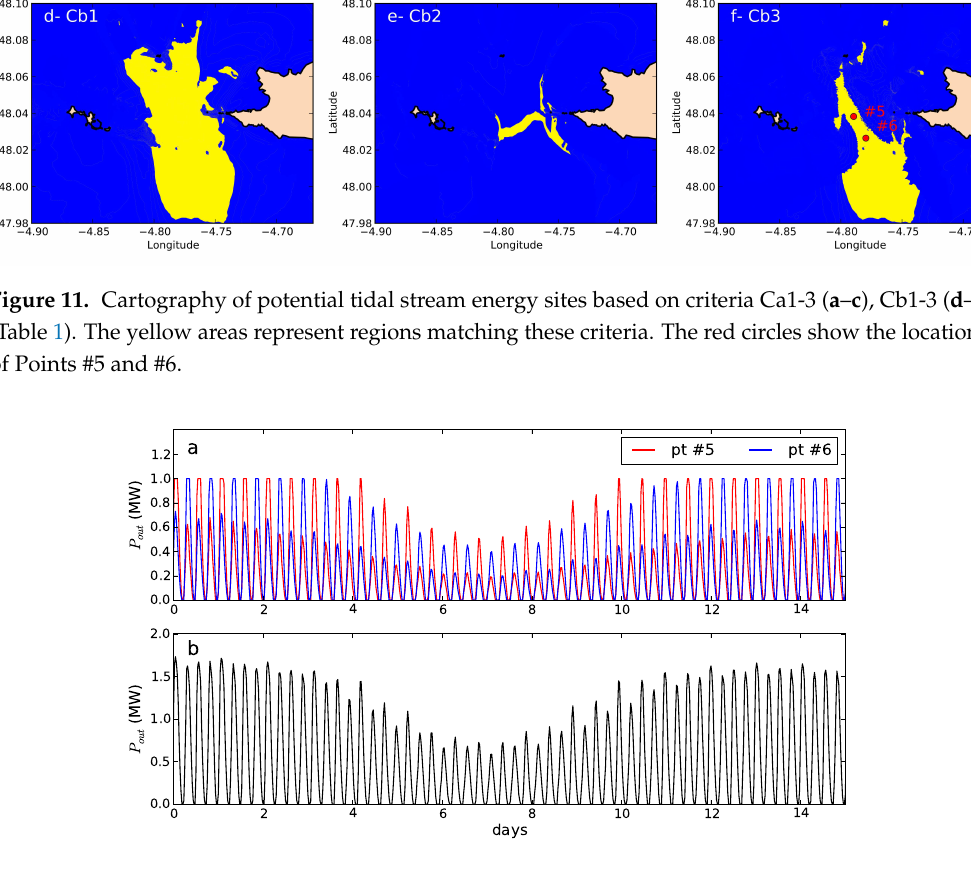
Figure 12. Generated practical powers at 10 m above the seabed from a 1 MW turbine with fixed axis (a) at points #5 and #6 along with (b) aggregated power P out ( #5 ) + P out ( #6 ) . axis ( a ) at Points #5 and #6 along with ( b ) aggregated power P out ( #5 ) + P out ( #6 )